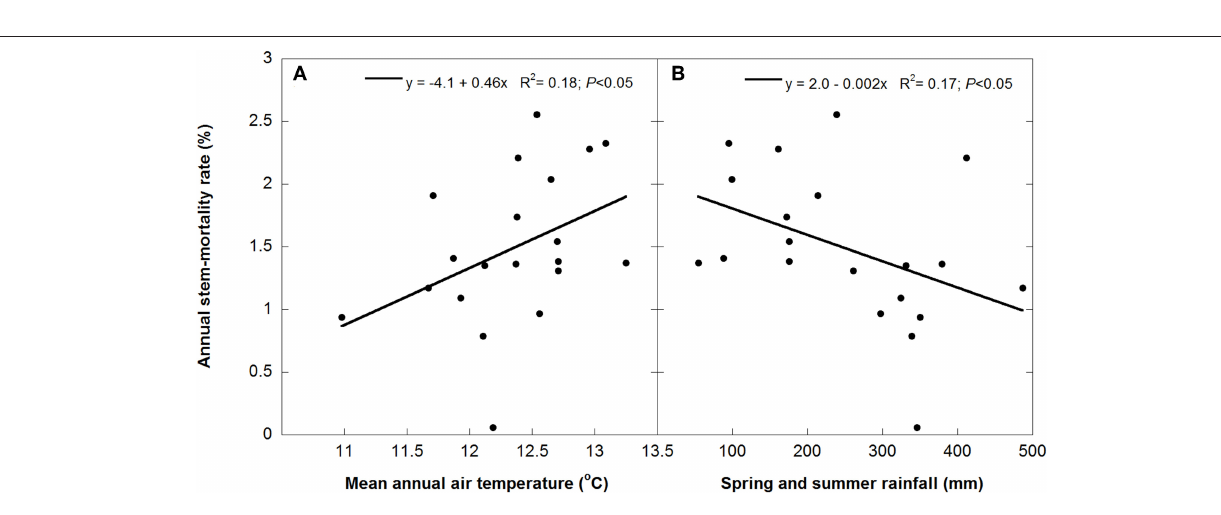
Frontiers in Forests and Global Change |